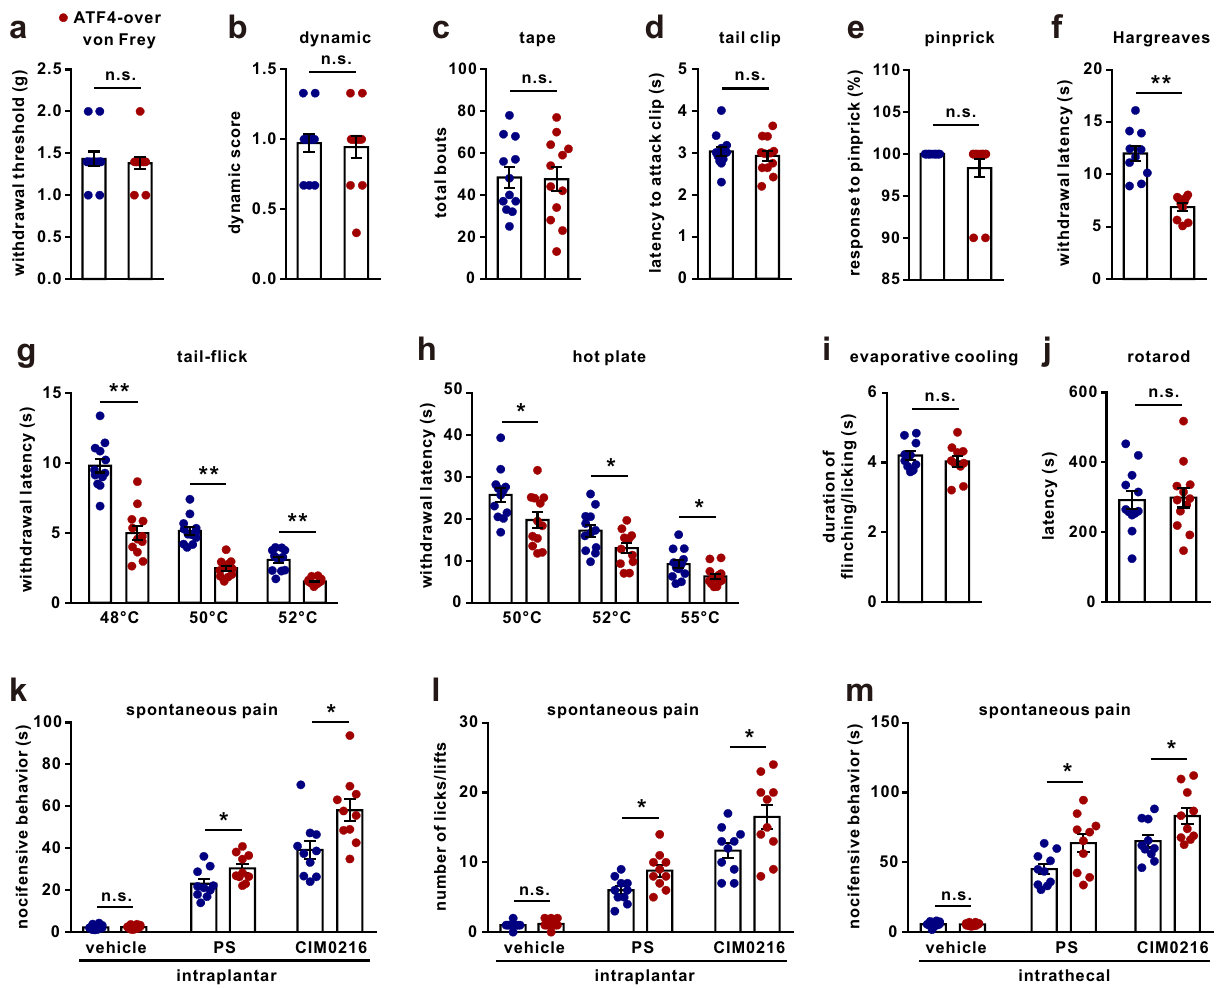
Fig. 4 Overexpression of ATF4 increases heat sensitivity. a – j The behaviours of ATF4-overexpressing and control mice were evaluated by the von Frey ( a ), dynamic ( b ), tape ( c ), tail clip ( d ), pinprick ( e ), Hargreaves ( f ), tail- fl ick ( g ), hot plate ( h ), evaporative cooling ( i ) and rotarod ( j ) tests. n = 12 mice per group in a – e , g , h , j . n = 10 mice per group in f , i . t 18 = 6.308, P < 0.0001 in f . t 22 = 6.893 , P < 0.0001 in 48 °C; t 22 = 8.009, P < 0.0001 in 50 °C; t 22 = 6.831, P < 0.0001 in 52 °C in g . t = 2.373, P = 0.0268 in 50 °C; t = 2.245, P = 0.0352 in 52 °C; t = 2.396, P = 0.0255 in 55 °C in h . k , l Spontaneous pain: 22 22 22 total duration ( k ) or number ( l ) of nocifensive behaviour (paw licking or f l inching within 2 min) in response to intraplantar injection of vehicle, PS (2.5 nmol/paw) or CIM0216 (2.5 nmol/paw) into control and ATF4-overexpressing mice. n = 10 mice per group. t 18 = 2.411, P = 0.0268 in PS; t 18 = 2.795, P = 0.0120 in CIM0216 in k . t 18 = 2.775, P = 0.0125 in PS; t 18 = 2.334, P = 0.0314 in CIM0216 in l . m Spontaneous pain: total duration of nocifensive behaviour (in 5 min) in response to intrathecal injection of vehicle, PS (1.25 nmol/paw) or CIM0216 (1.25 nmol/paw) into control and ATF4-overexpressing mice. n = 10 mice per group. t = 2.506, P = 0.0220 in PS; t = 2.46, P = 0.0242 in CIM0216. a – m , Two -t ailed Independent Student ’ s t test, * P < 0.05, ** P < 18 18 0.01, n.s. means not signi fi cant. The error bars indicate the